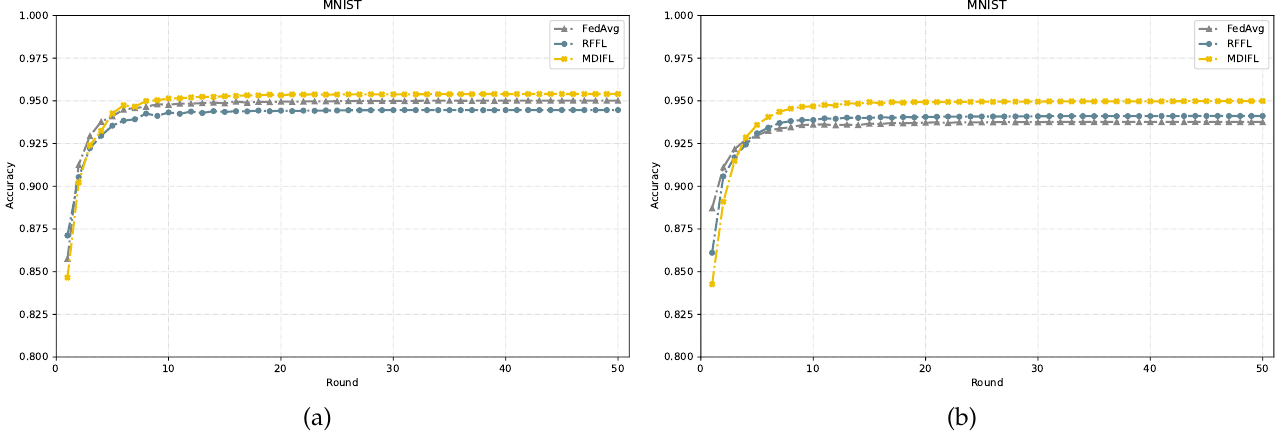
Figure 4. Accuracy comparison of MDIFL, FedAvg and RFFL. ( a ) Ten honest participants and 20% of S_P under UNI split MNIST. ( b ) Ten honest participants and 20% of S_P under POW split MNIST.